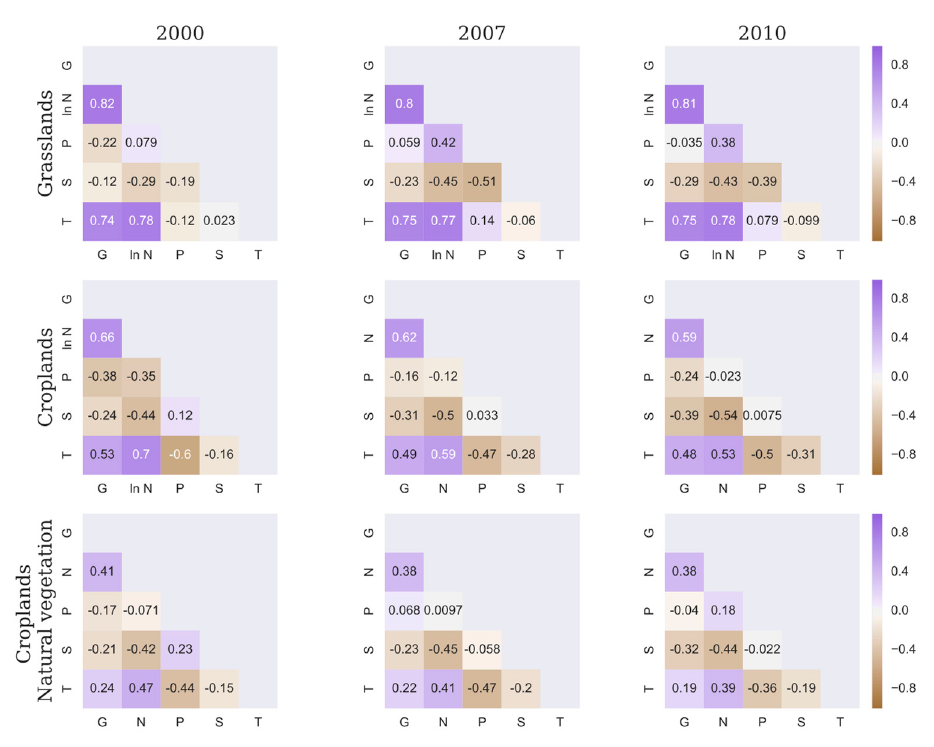
Figure 2. Correlation matrix between the dependent and independent variables per year and land cover class (p < 0.01 mostly, see Appendix Table A 1–3). G: GPP, N: N deposition, ln N: